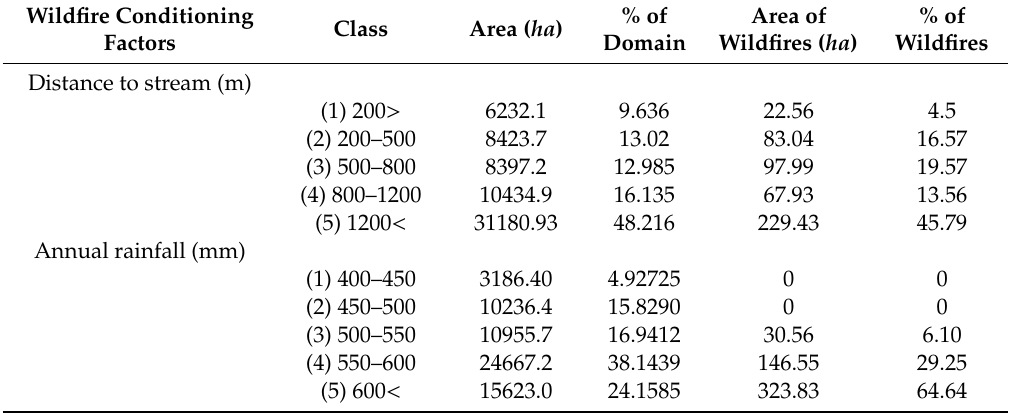
Table 2. The conditioning hydrological factors, the area of classes, and percent of the wildfire-a ff ected areas in each class.